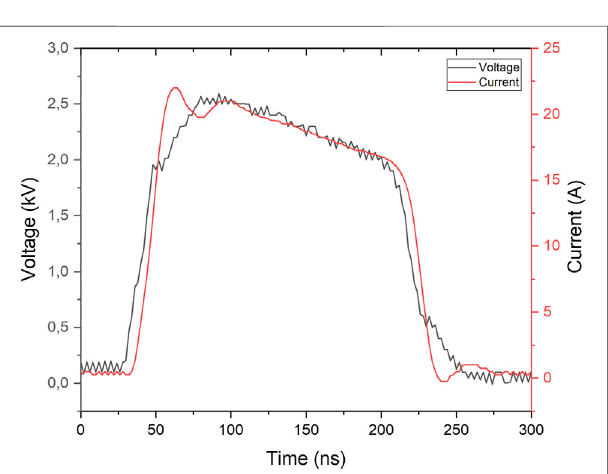
FIGURE 4 | Typical electrical characteristic of the PEF applied in the electroporation cuvette with PAW.